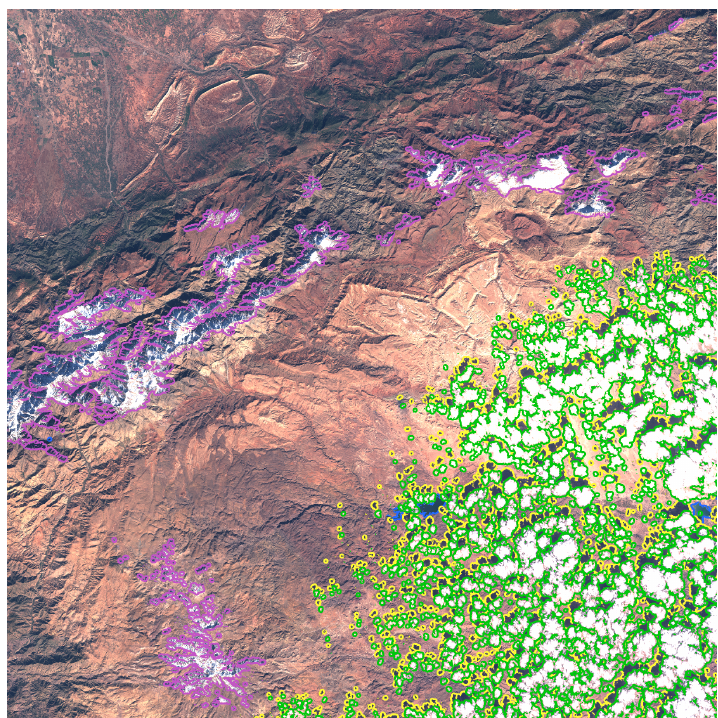
Figure 3. Visualization of the reference mask for the Marrakech site, Tile 29RPQ, on 18 November 2017. clouds are outlined in green, cloud shadows in yellow, water in blue, and snow in purple.